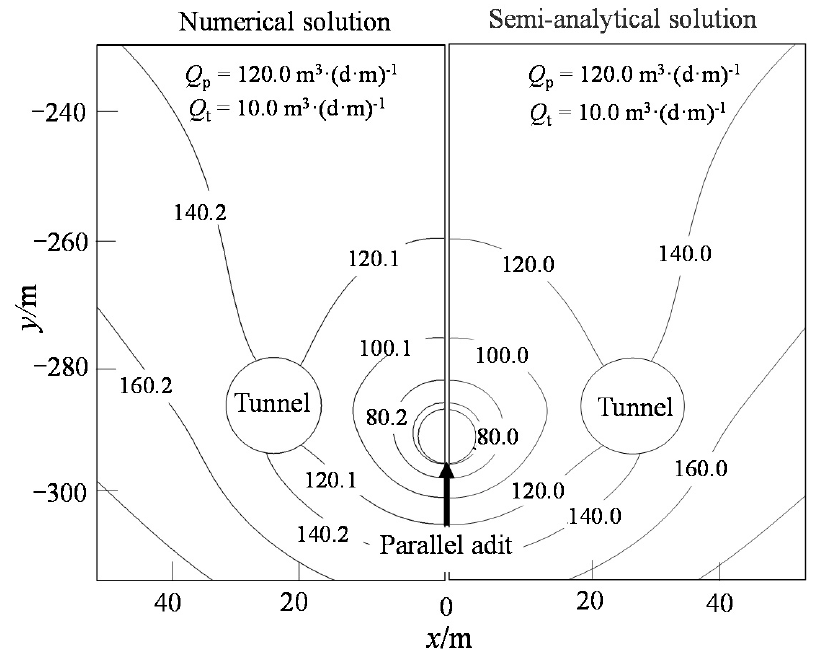
Figure 10. Pressure head contour map.